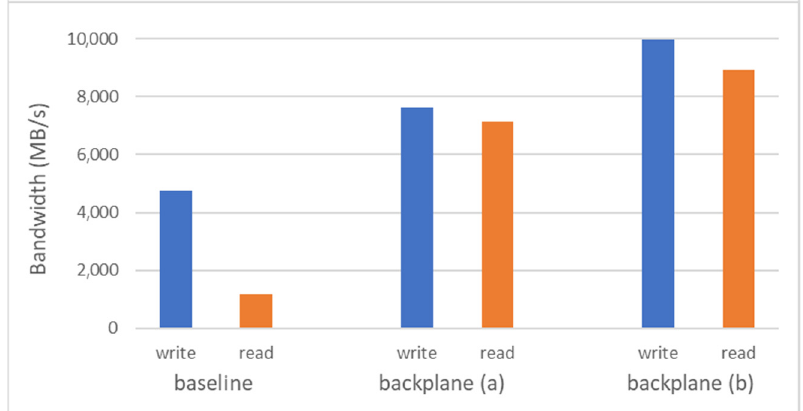
Figure 6. Comparisons of the performance of remote direct accelerator memory access based on PCIe peer-to-peer communication in the case of the baseline and the backplane-based system. The backplane cases ( a ) and ( b ) differ in the internal HBM interface clock frequency, 250 MHz and 450 MHz, respectively.